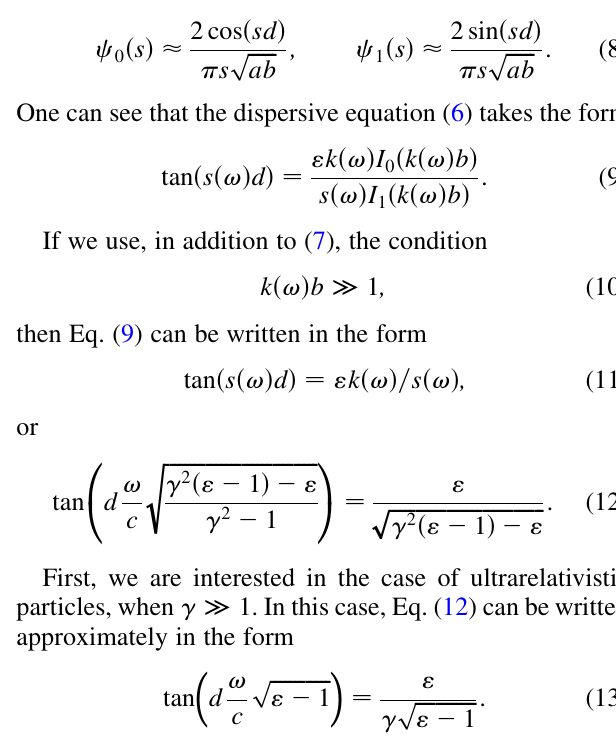
ffiffiffiffiffiffiffiffiffiffiffiffi p " (cid:1) 1